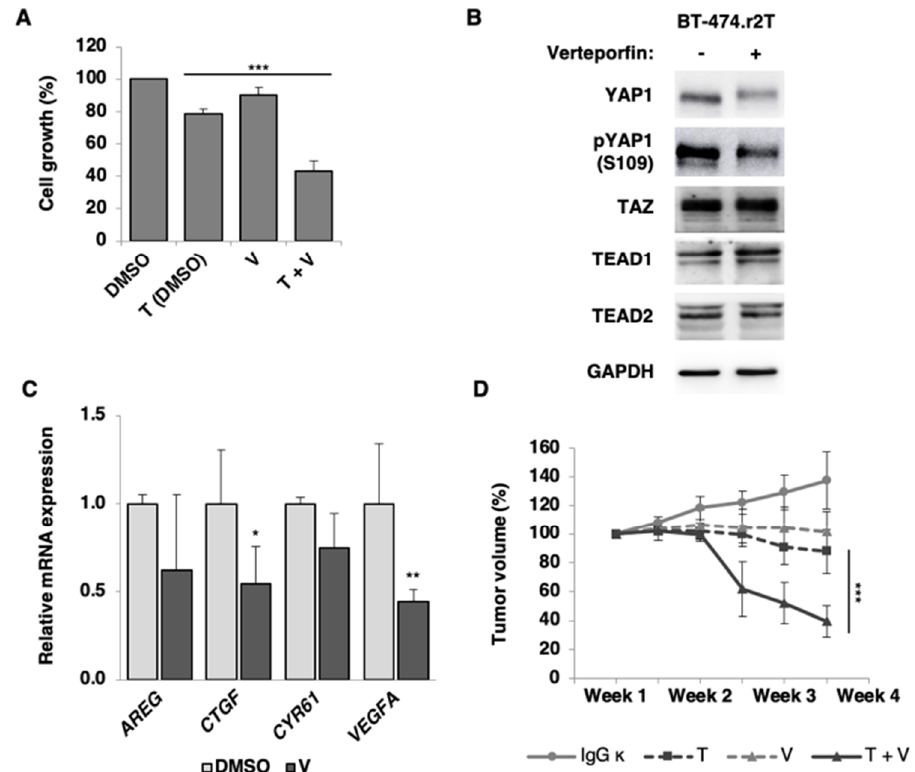
Figure 6. Verteporfin-mediated regulation of the YAP1 / TEAD signaling pathway restores sensitivity to antitumor activity of trastuzumab in BT-474.r2T cell line. ( A ) For in vitro experiments, 2.5 × 10 6 BT-474.r2T cells were seeded in 6-multiwell plates, and treatments were initiated after 96 h. For cell proliferation assays, BT-474.r2T cells left untreated (DMSO control), treated with 15 µ g / mL trastuzumab, with 50 nM verteporfin, or with a combination of trastuzumab and verteporfin for 7 days. ( B ) WB of YAP1, pYAP1, TEAD1, and TEAD2 proteins were extracted after 48 h of 5 µ M verteporfin treatment. Data are representative out of at least three independent replicates. ( C ) For the mRNA expression analyses of AREG , CTGF , CYR61 , and VEGFA , cells were left untreated (DMSO control) or treated with 5 µ M verteporfin for 2 h. ( D ) Combination of trastuzumab and verteporfin decreases tumor proliferation and enhances apoptosis in mouse BT-474.r2T xenografts resistant to trastuzumab. Tumor verteporfin, and combined trastuzumab with verteporfin groups of